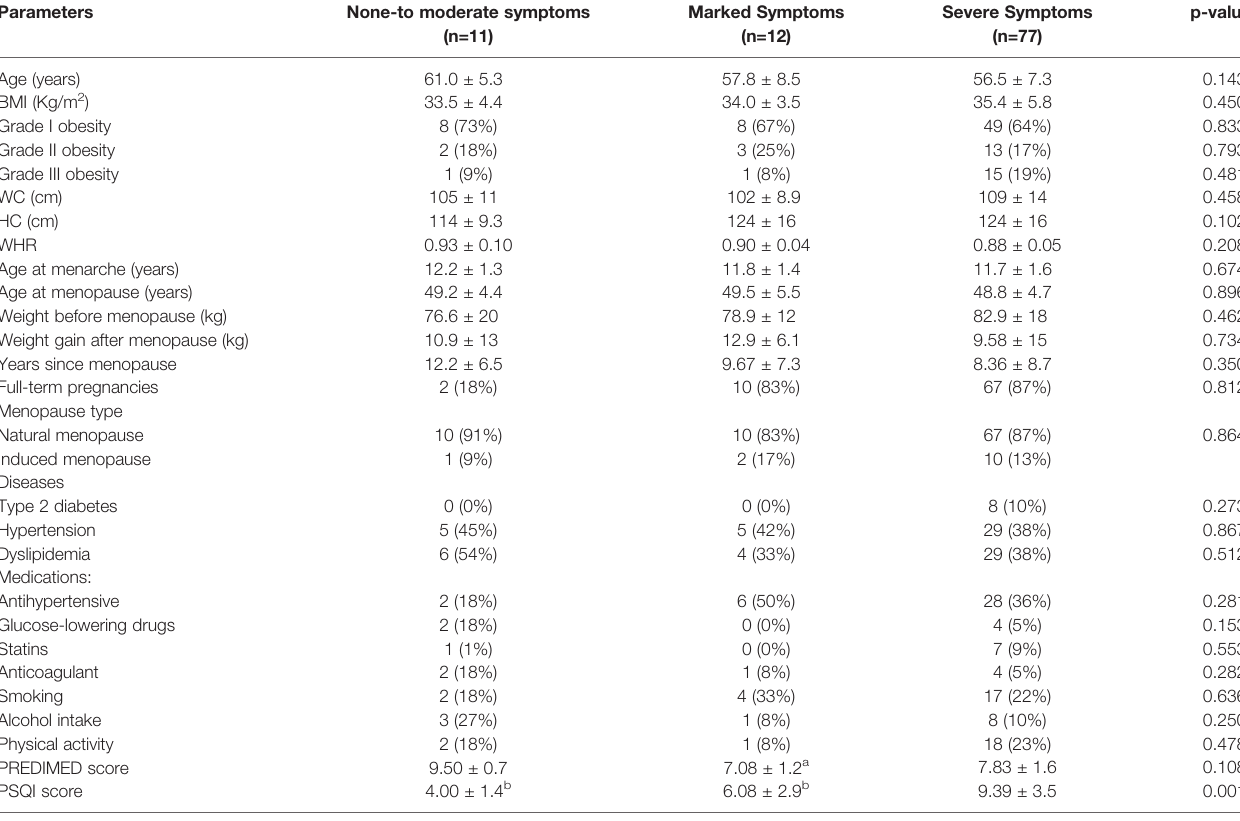
TABLE 3 | Demographic, anthropometric and medical, lifestyle habits, adherence to the Mediterranean diet, and sleep quality of participants strati fi ed by severity of menopausal symptoms (MRS).